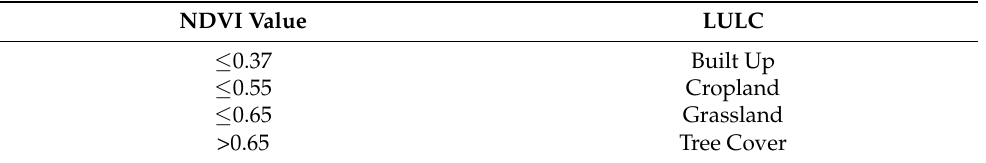
Table 2. LULCs for each NDVI value